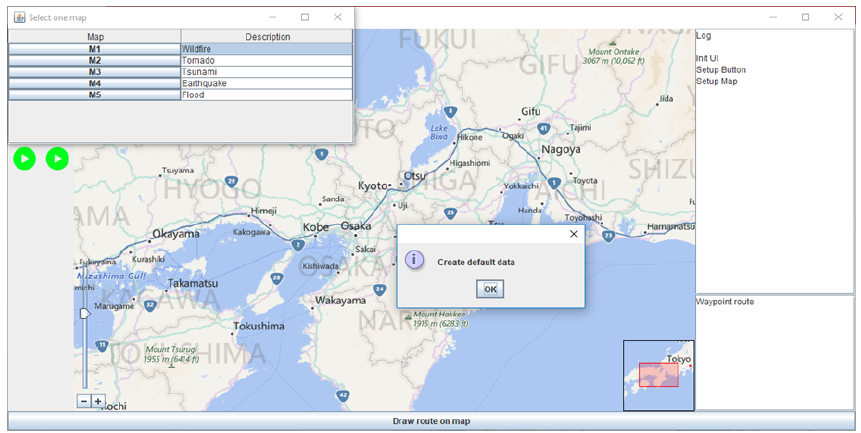
Figure 10. Identification of emergency locations in Japan on the Google